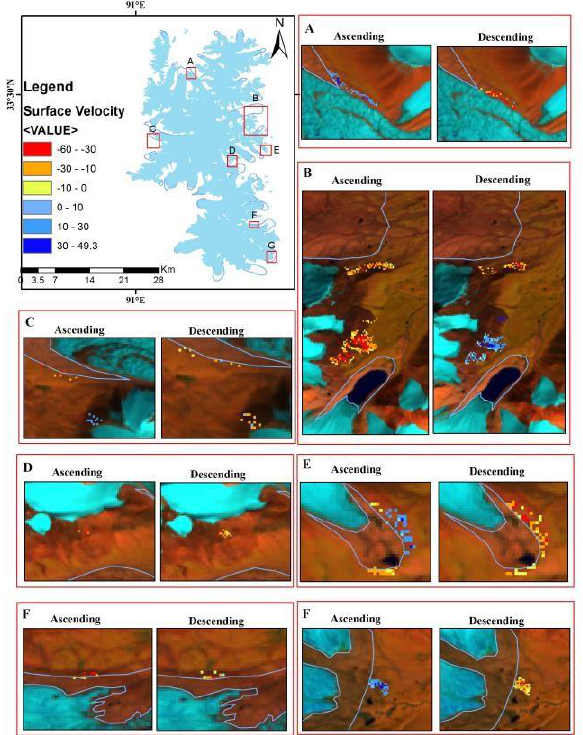
Figure 4. Surface deformation on glacier retreated surrounding